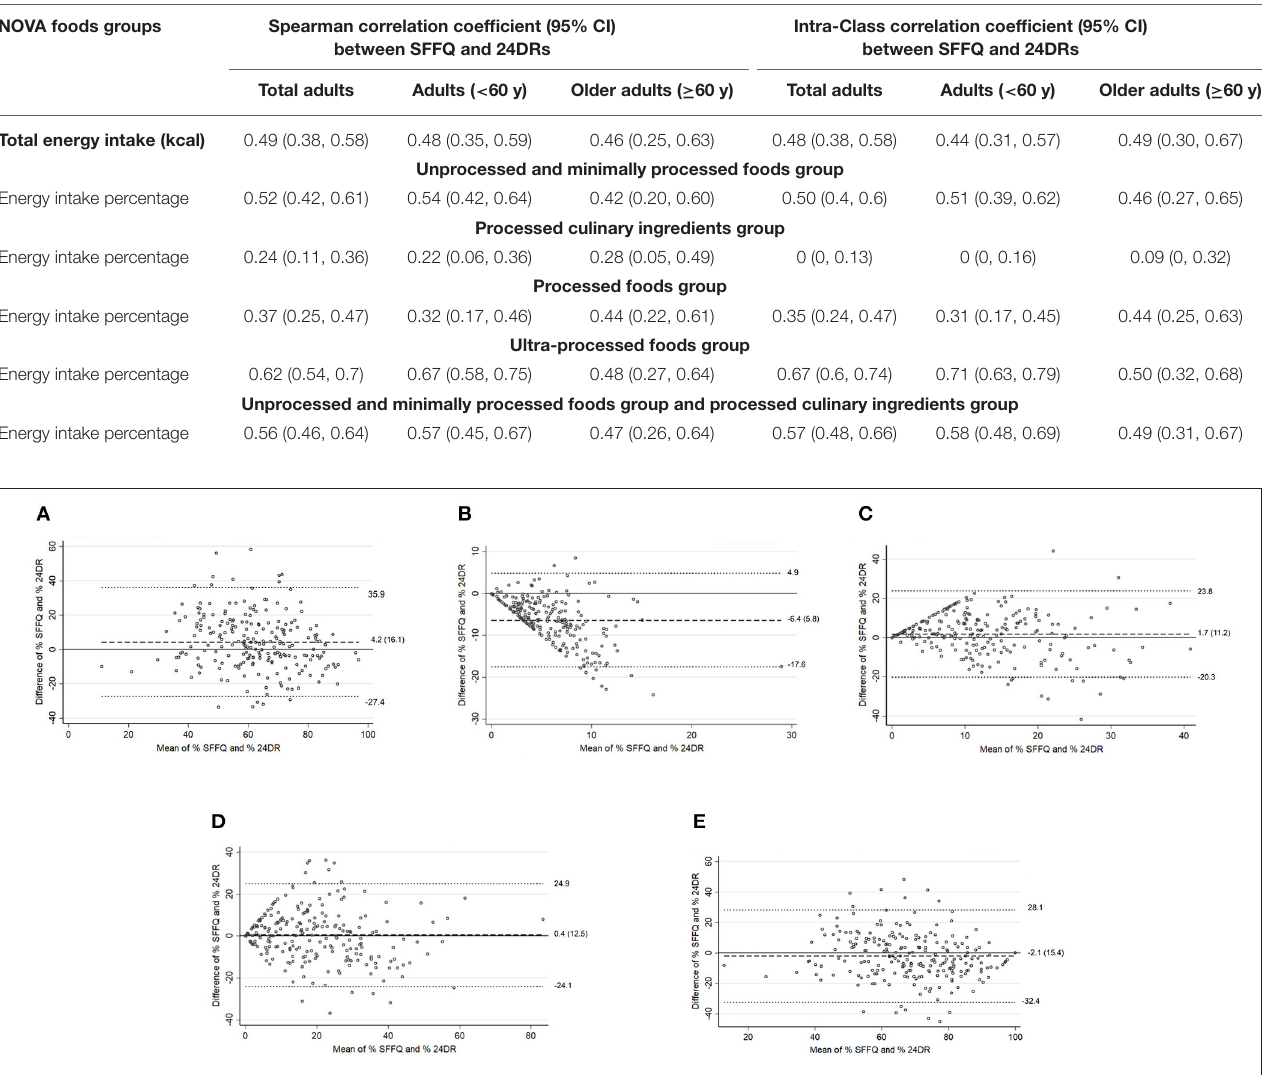
TABLE 3 | Correlation between SFFQ and 24DRs in adults and older adults in NOVA foods groups. NOVA foods groups